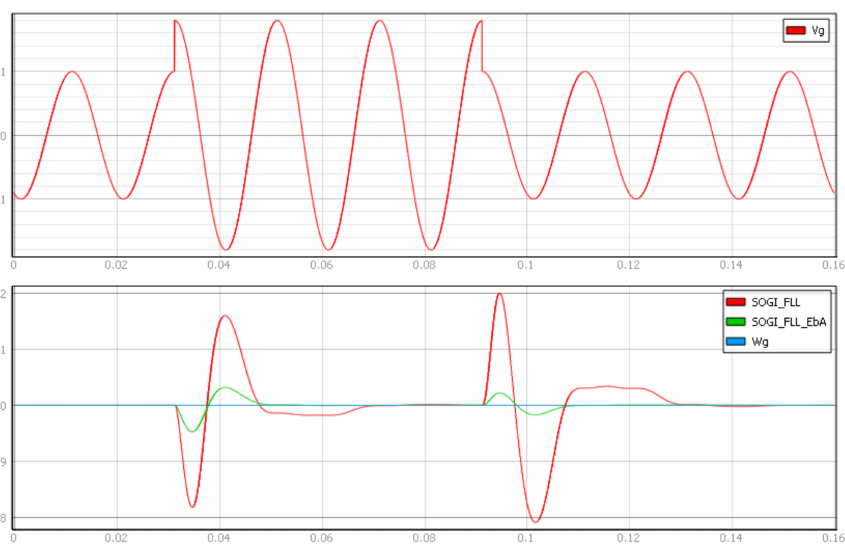
Figure 13. HIL results for the SOGI-FLL and SOGI-FLL-EbA to short-duration voltage swell. ( up ) Grid voltage swell fault going from 1 pu to 1.8 pu and going back to 1 pu. ( down ) SOGI-FLL (red) and SOGI-FLL-EbA (green) estimated frequency response to the voltage sag in